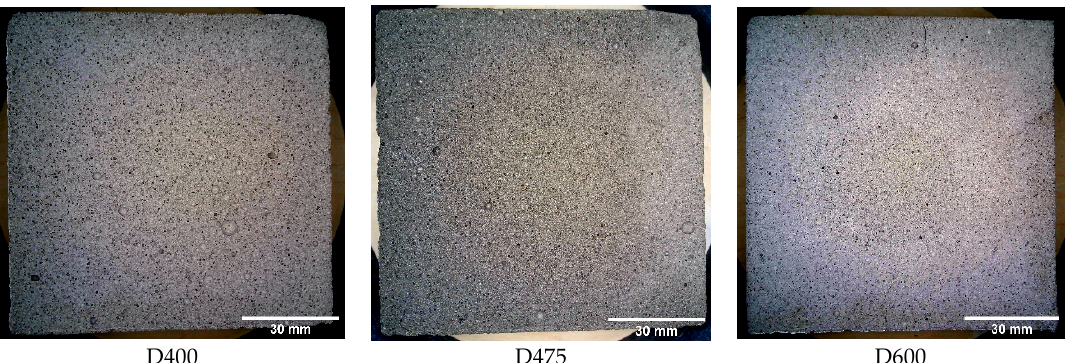
Figure 1. Lightweight cellular concrete specimens with different densities.